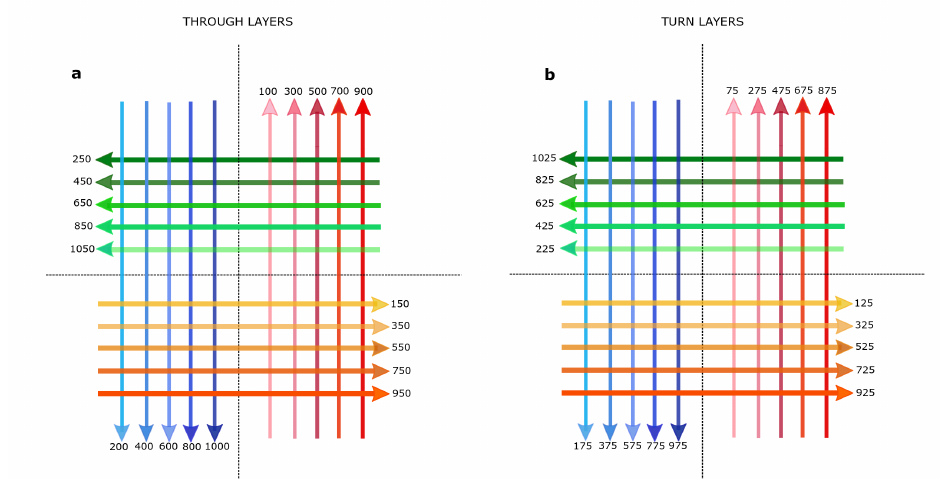
Figure 4. Traffic flow at a typical four-leg intersection for the two-way airspace concept. The traffic is vertically segmented into different altitudes with respect to their travel direction. Note that the altitudes are presented in ft. ( a ) Altitude layers belonging to the through traffic, which 20 altitude layers consist. ( b ) Altitude layers allocated for turn traffic, which consist of 20 individual altitude layers. Of note, the through-layers accommodate traffic that pass through at least one intersection, while turn-layers accommodate traffic that is decelerating to make a turn at the intersection.